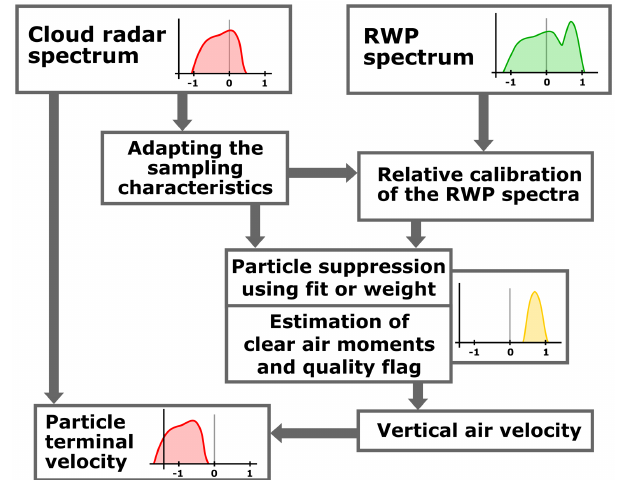
Figure 4. Scheme of the separation algorithm. The separation be- gins with the raw measurements from cloud radar and RWP as de- noted in the top row. The separation between particle and clear-air signal is performed after adaption of the different sampling char- acteristics and relative calibration. The products are the quality flagged vertical air velocity and the particle terminal velocity. Fur- ther description is in the